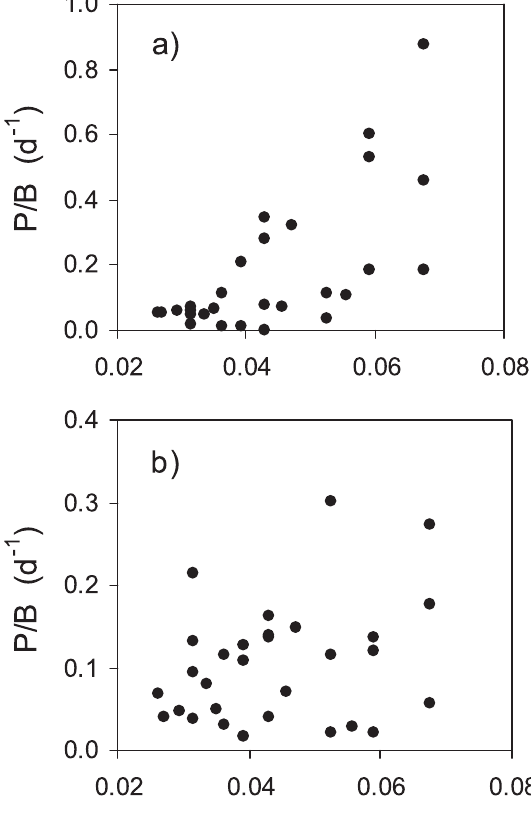
Fig . 10. – Relationship between K (d -1 ) and surface size-fractionat- d ed phytoplankton growth rate. a) picophytoplankton; b) phytoplank- ton >2 m